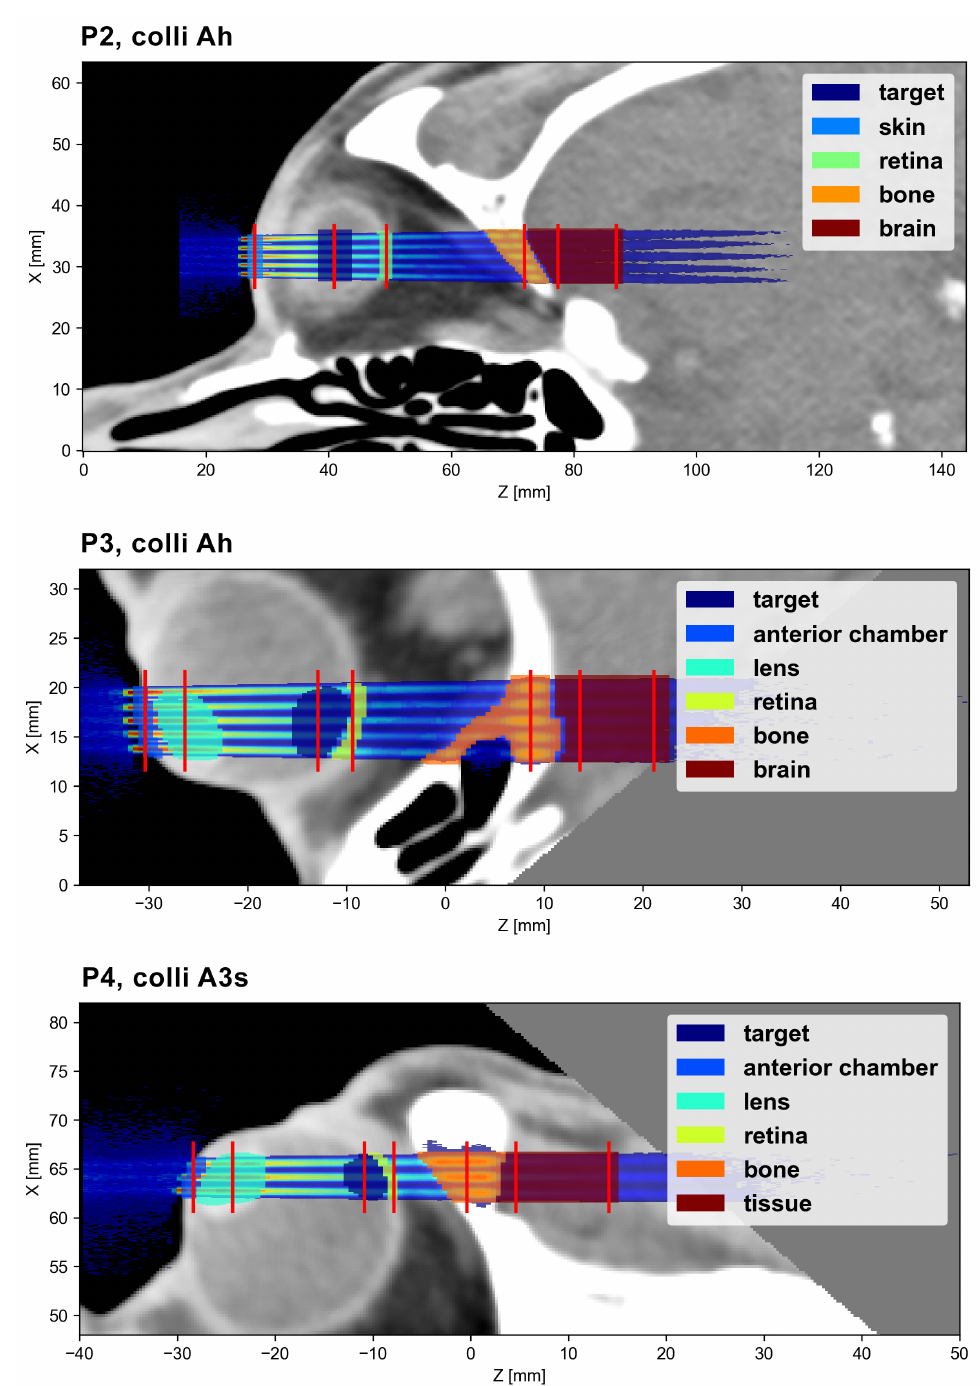
Figure 4. The ROIs and the lateral profile sampling positions (red lines) for the P2, P3 and P4 cases. The dose distributions were acquired by combining the results of 300 independent simulation instances. The dose uncertainty was assessed in each voxel by computing the standard deviation over these 300 instances. As a global uncertainty score, the relative mean uncertainty was computed, considering only voxels in the analysed region of the dose distribution. This was done to exclude very-low-dose regions which are irrelevant to the final dose analysis but which would have drastically increased and distorted the global uncertainty. The exact regions used for the global uncertainty score are indicated by the dashed yellow lines in Figure 5. The mean relative uncertainty was < 4% in all cases (Table